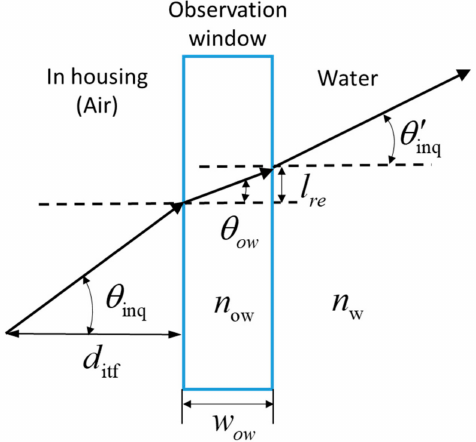
Figure 9. Light path of the laser emitted by the base station.